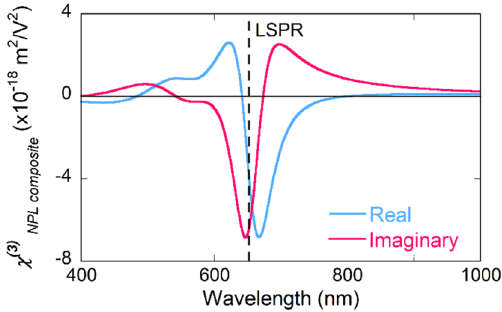
Figure 3. Real (blue) and imaginary (blue) components of third-order susceptibility of Au triangular nanoplates embed in PVA matrix. The straight dashed line represents the wavelength of linear